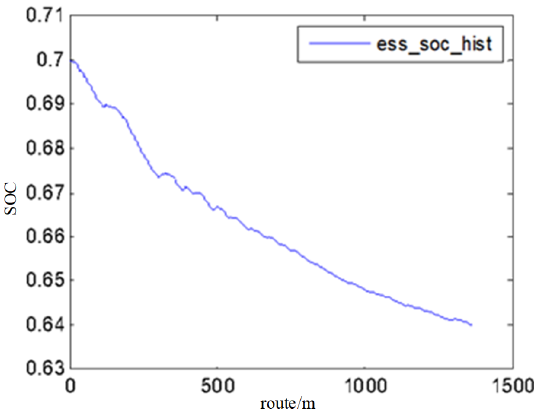
Figure 22. Fuzzy control motor power SOC .